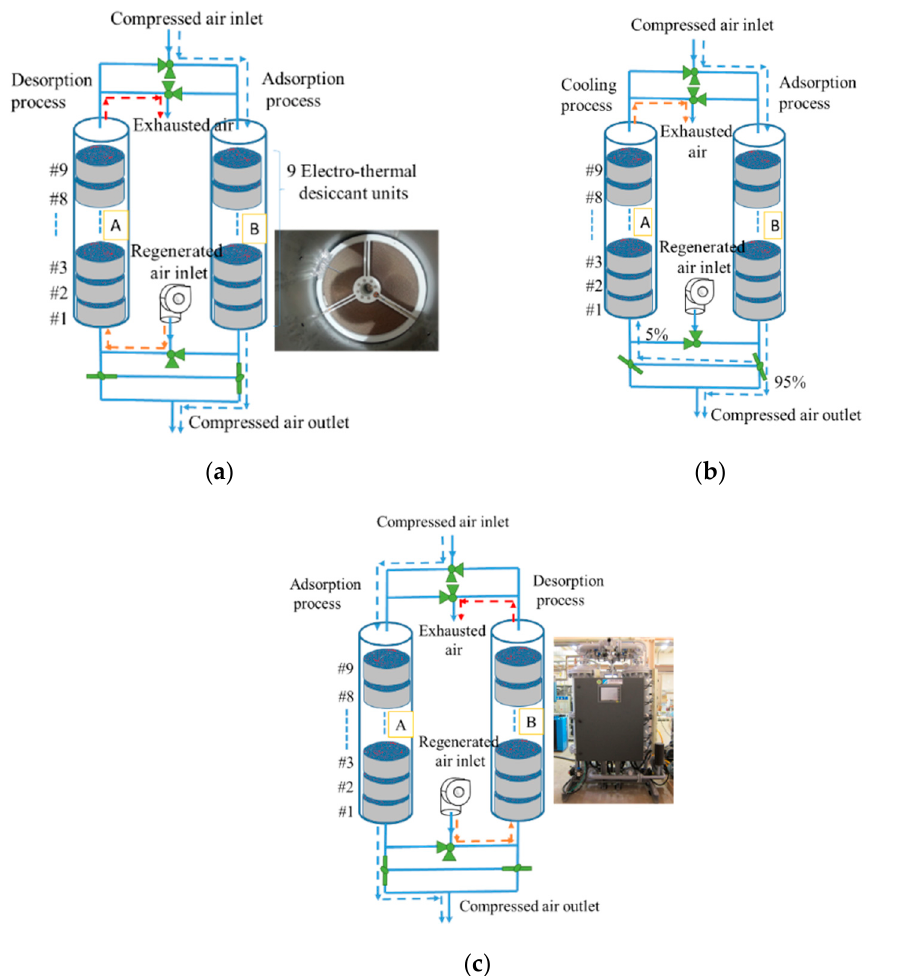
Figure 15. System configuration of an ETAU compressed air dryer: ( a ) regeneration, ( b ) cooling, ( c ) and adsorption steps in tower